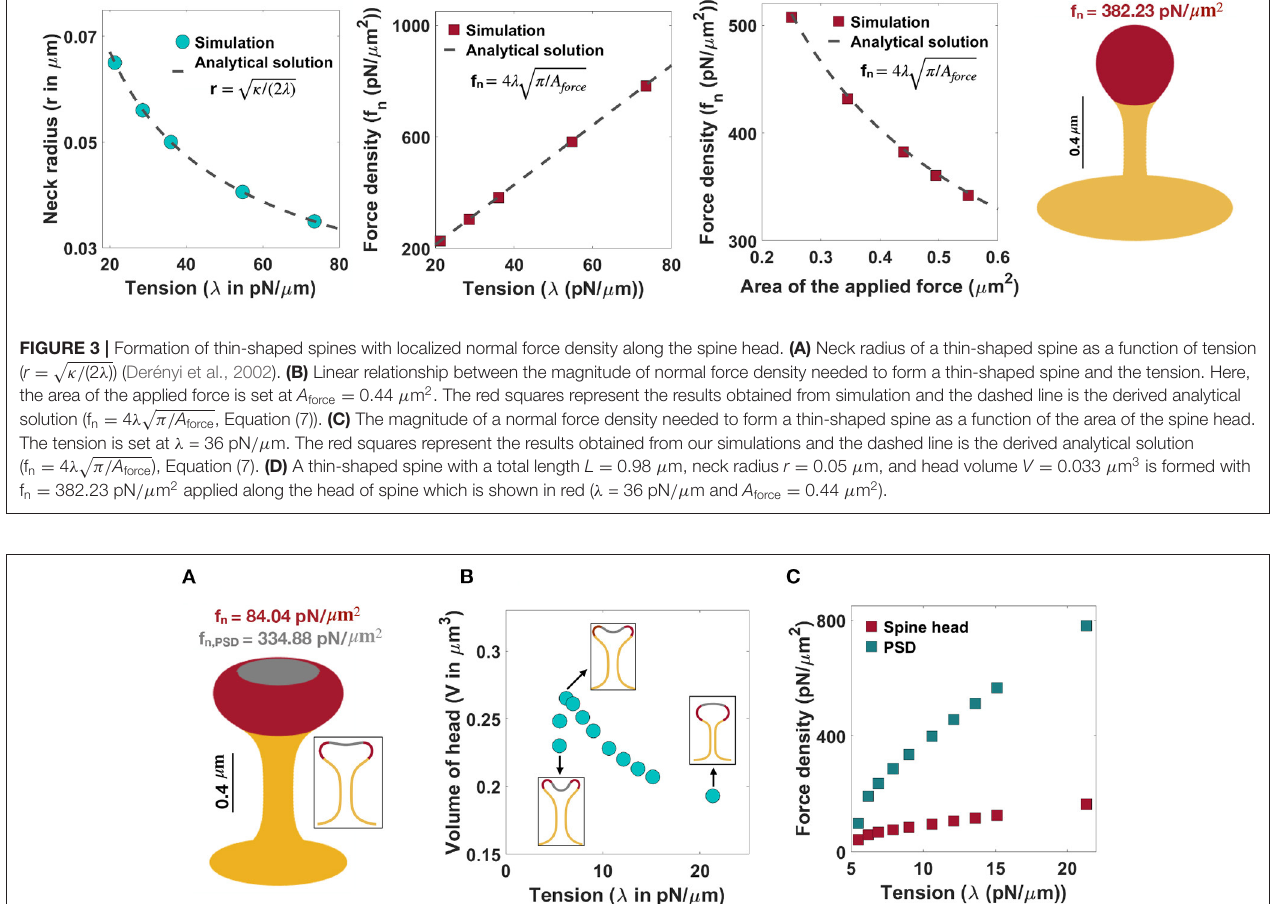
Figure 5C , we plotted the axial force as a function of tension and spontaneous deviatoric curvature. We found that for a fixed value of tension, the axial force has a local minimum along the red line ( Figure 5C ) where λ = κ D 2 ( Supplementary Equation 38 ) and m F z,min = 2 πκ D m ( Supplementary Equation 38 ). The 3D surface in Figure 5C can be reduced to a single curve by defining the effective axial force as F z 2 πκ D m and plotting it as a function + of effective tension ( Supplementary Figure 6D ). We also